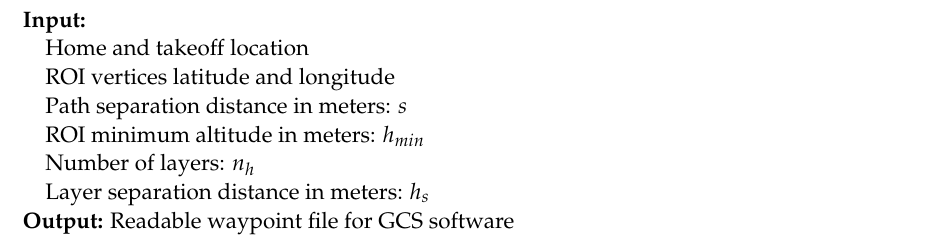
Algorithm 2 Circling-forward Path